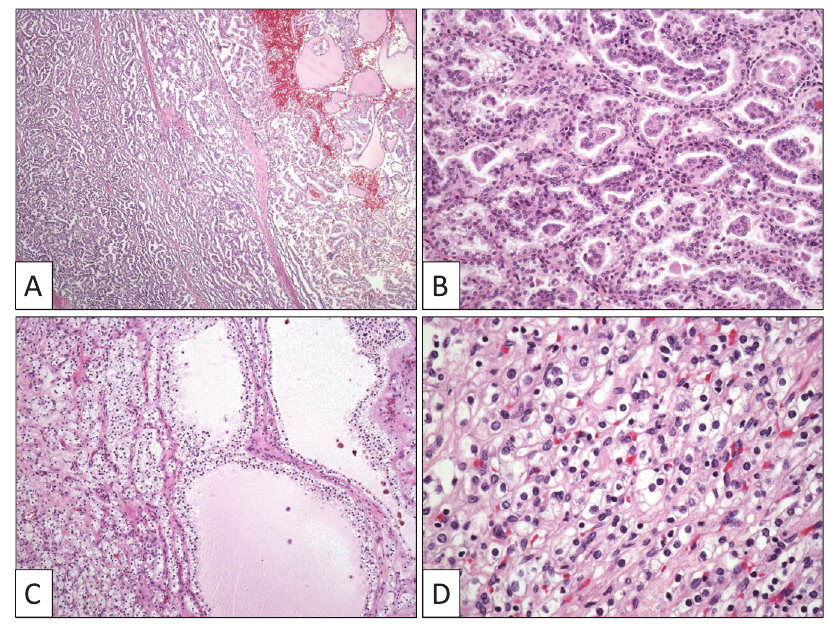
Figure 2. Panoramic view of both tumors, Biphasic squamoid alveolar renal cell carcinoma (BSARCC) ( A and B ) and conventional renal cell carcinoma (CCRCC) ( C and D ). BSARCC displayed some areas of type1 papillary renal cell carcinoma ( A , right side) and presented the typical alveolar structures filled with large cells ( A , left side and B ). CCRCC showed solid and cystic areas composed of nests low-grade cells with clear cytoplasm ( C and D ).